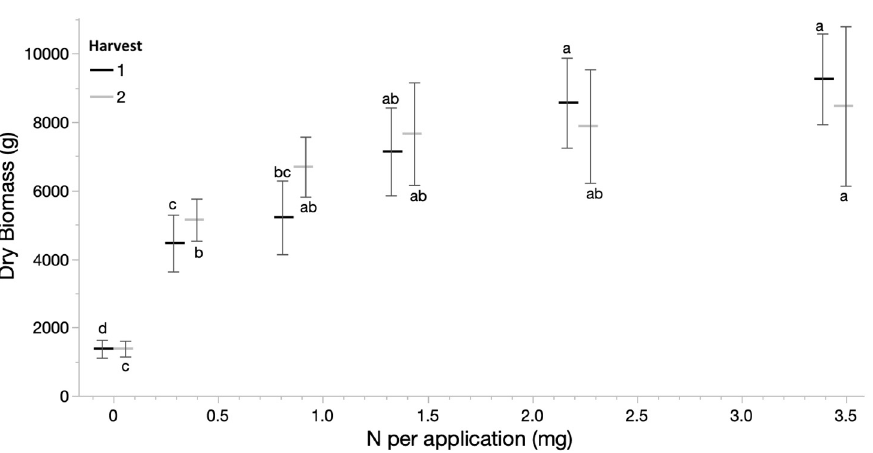
Figure 1. Mean dry biomass and 95% confidence intervals of sugarcane in Harvests 1 and 2 of the experiment, in response to nitrogen application per plant per fertilization period. Connecting letters denote Tukey’s HSD for each Harvest independently.